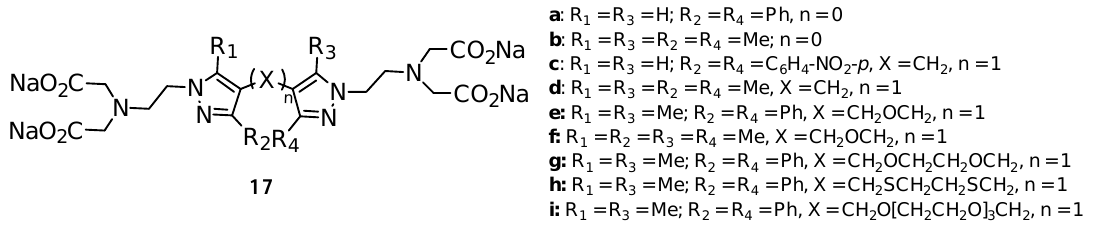
Figure 3 . Chelating ligands for Gd(III) with Bi and bis-pyrazole